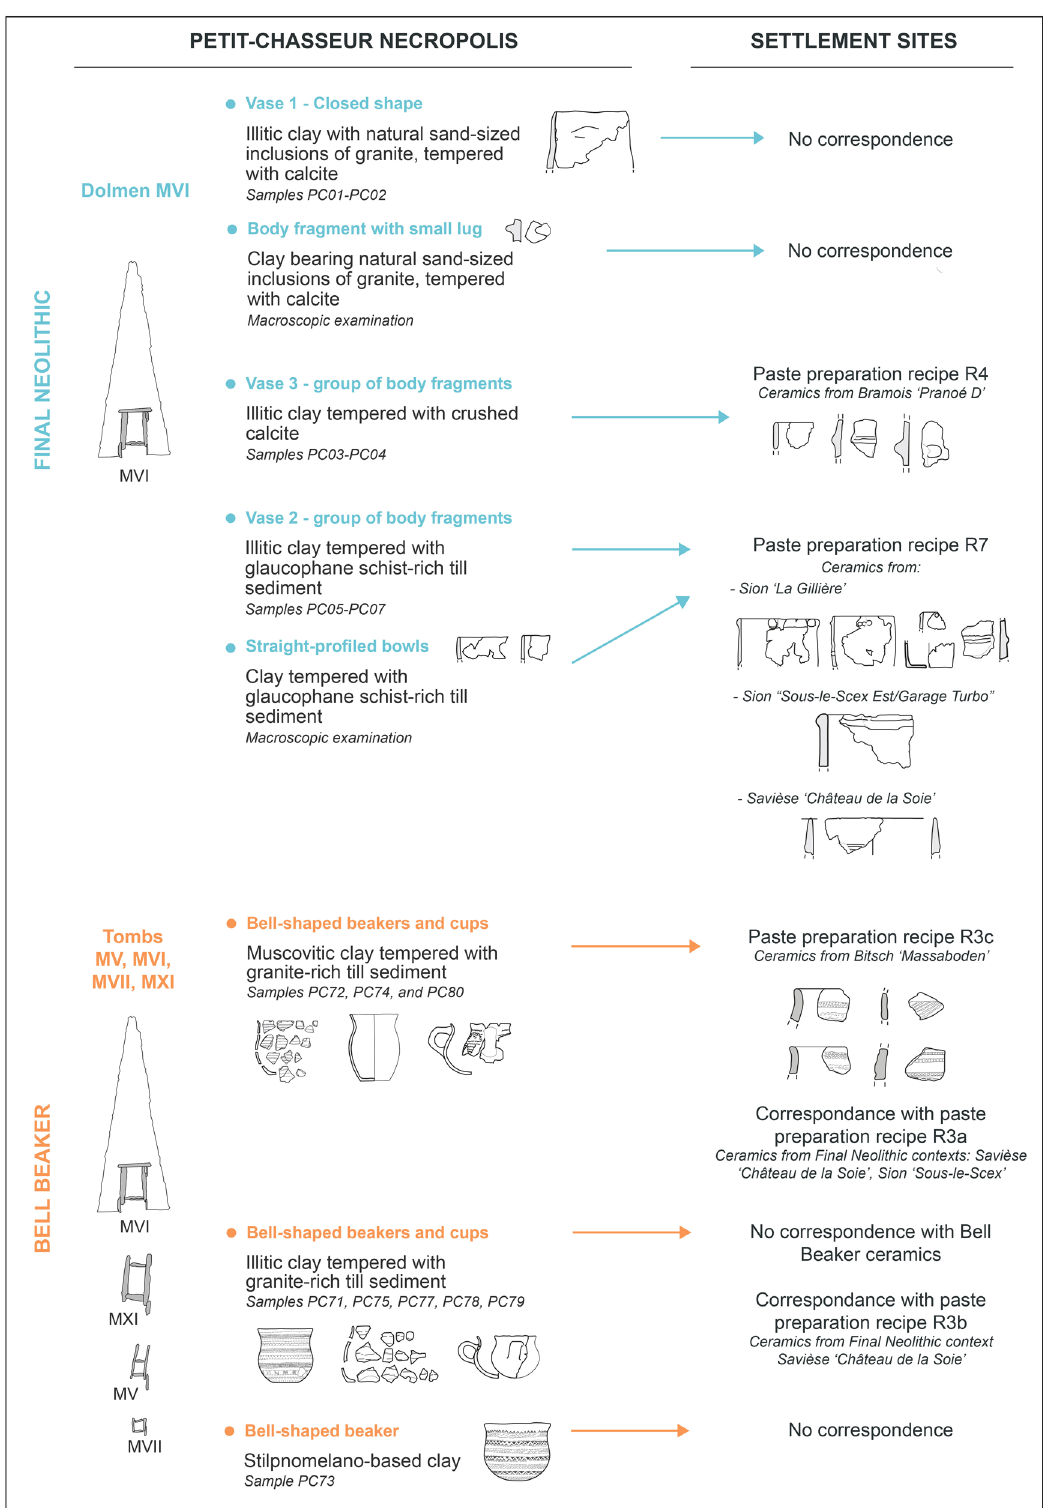
Figure 11: Correspondence between the raw material choices and exploitation patterns reconstructed for the Petit - Chasseur FN and BB ceramic grave goods ( Carloni et al., 2021 ) and the pottery from contemporaneous settlement sites in the